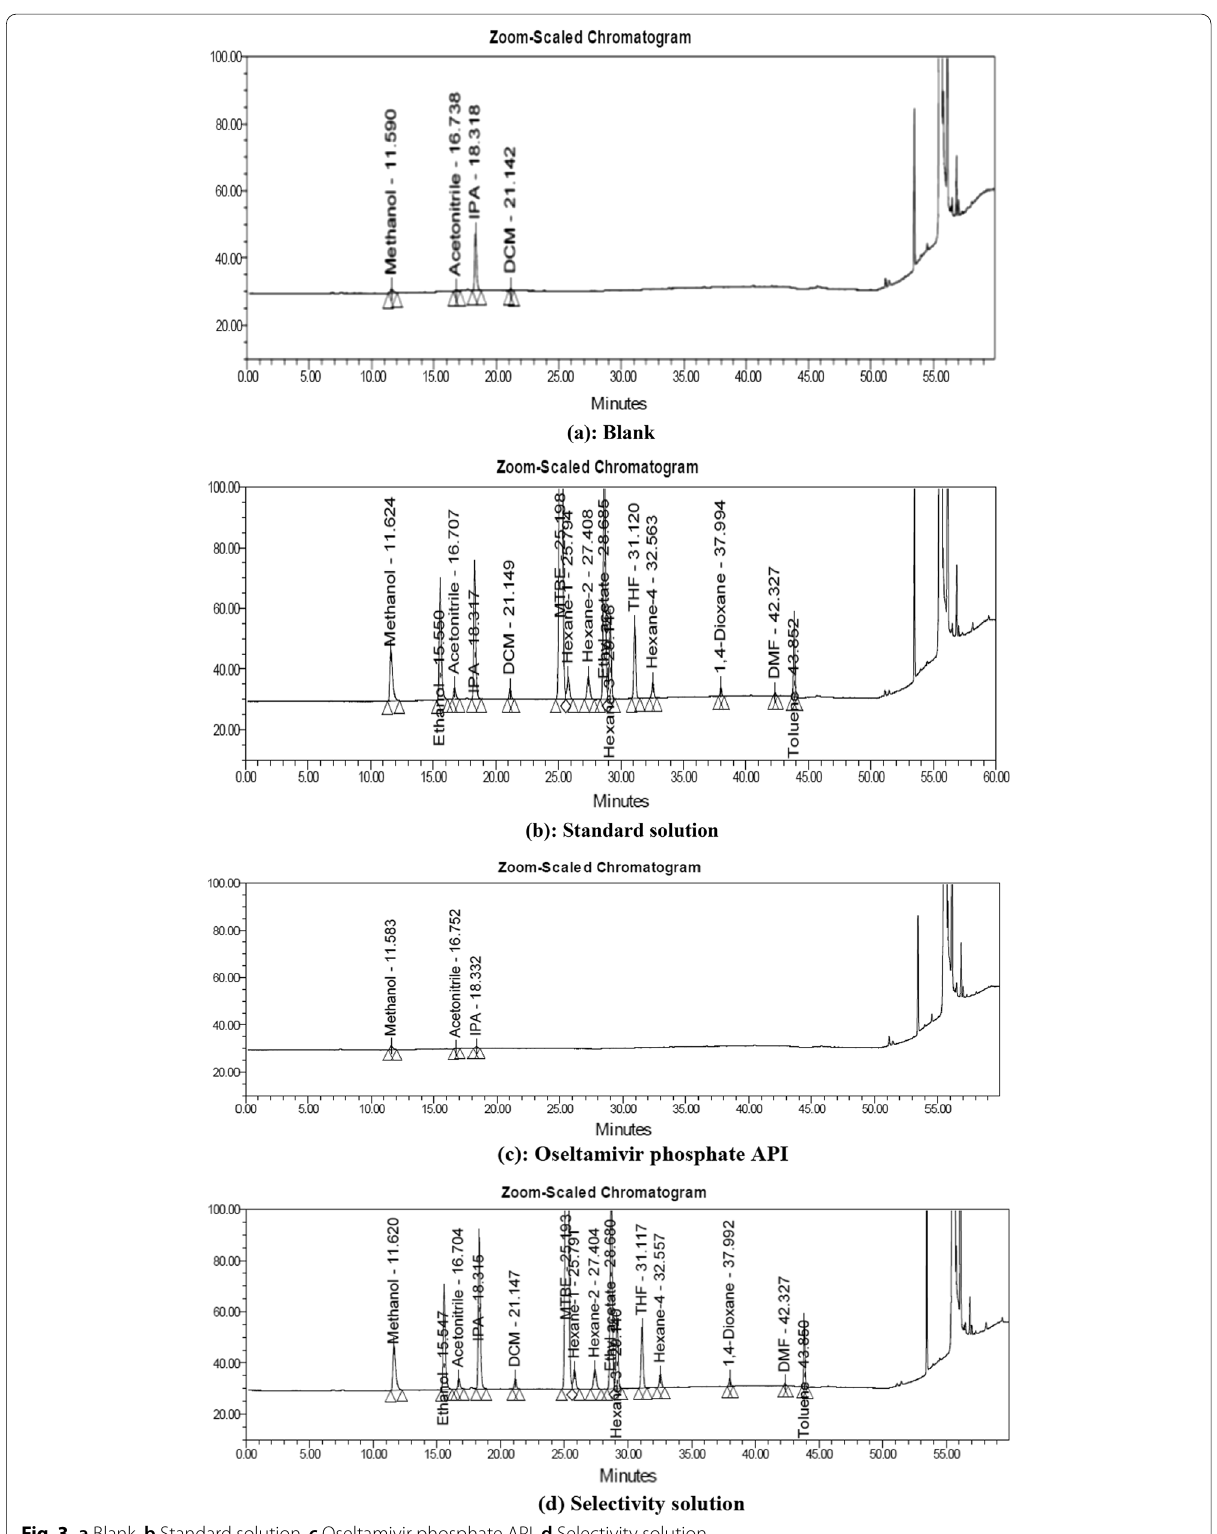
Fig. 3 a Blank, b Standard solution, c Oseltamivir phosphate API, d Selectivity